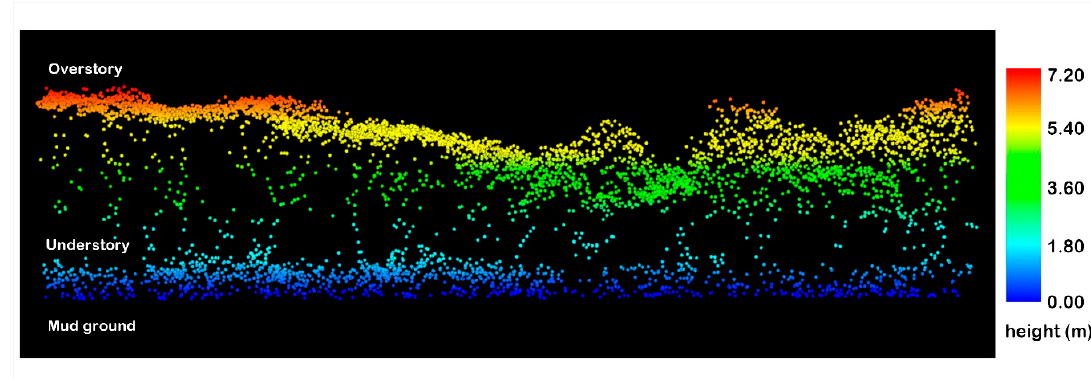
Figure 2. Illustration of mangrove vertical profile produced from LiDAR data in the study area. The LiDAR point cloud is displayed by height and the location of sample area is shown in Figure 1.